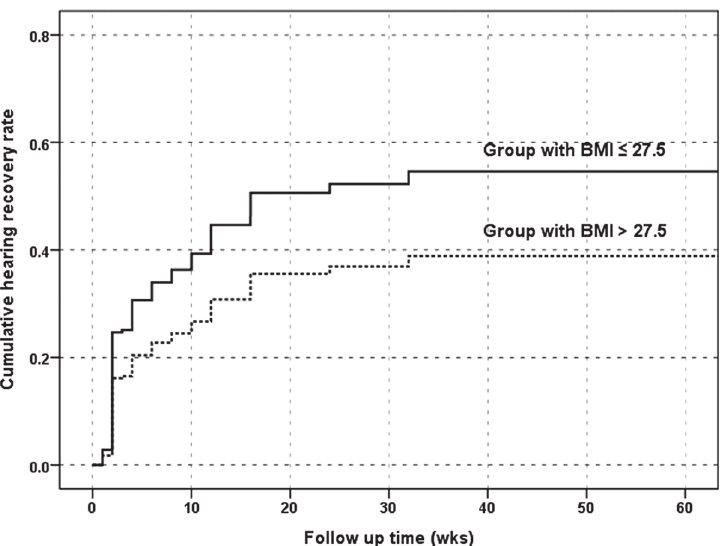
Fig 1. Cumulative complete hearing recovery rate according to body mass index (BMI). Cumulative complete recovery rate between subjects with body mass index (BMI) equal to or greater than grade III, and those with BMI less than grade II. The hazard ratio of poor response with patients with BMI equal or higher than grade III was 1.606 (95% confidence interval: 1.03 –